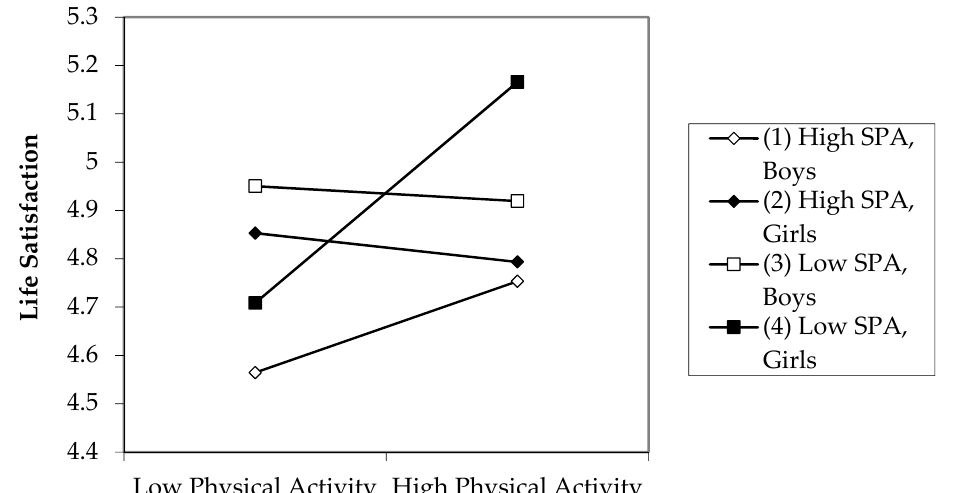
Figure 2. Three-way interaction of physical activity (baseline), social physique anxiety (baseline), and sex on life satisfaction (follow-up). Notes: SPA = social physique anxiety.